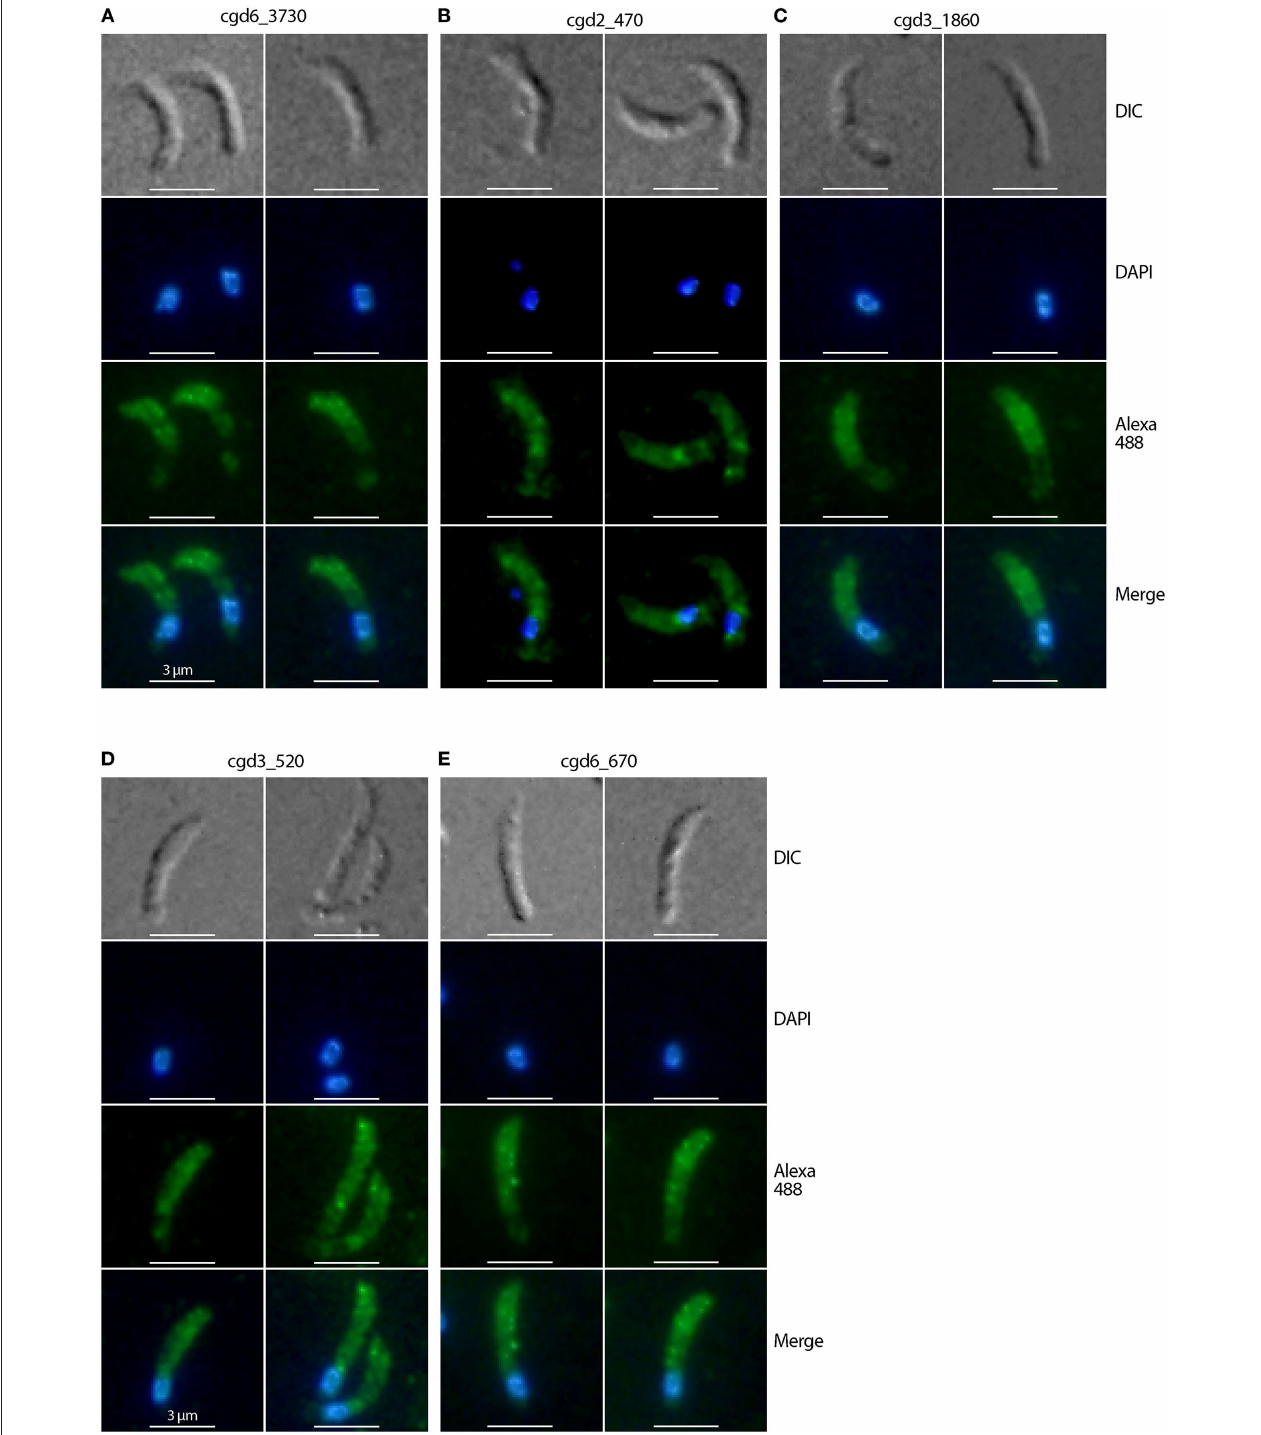
FIGURE 2 | Immunofluorescence micrographs of five Cryptosporidium parvum proteins showing non-micronemal distribution. The proteins are cgd6_3730 (signal peptide, peptidase S8/S53 domain containing protein) (A) , cgd2_470 (uncharacterized protein) (B) , cgd3_1860 (EGF-like domain containing extracellular protein) (C) , cgd3_520 (PAN/Apple domain containing protein) (D) , and cgd6_670 (aspartic acid and asparagine hydroxylation/peptidase C11) (E) . Proteins were labeled with Alexa Fluor 488 (green) and the nuclei were counterstained with 4,6-diamidino-2-phenylindole (DAPI) (blue). The morphology of sporozoites was determined using differential interference contrast microscopy